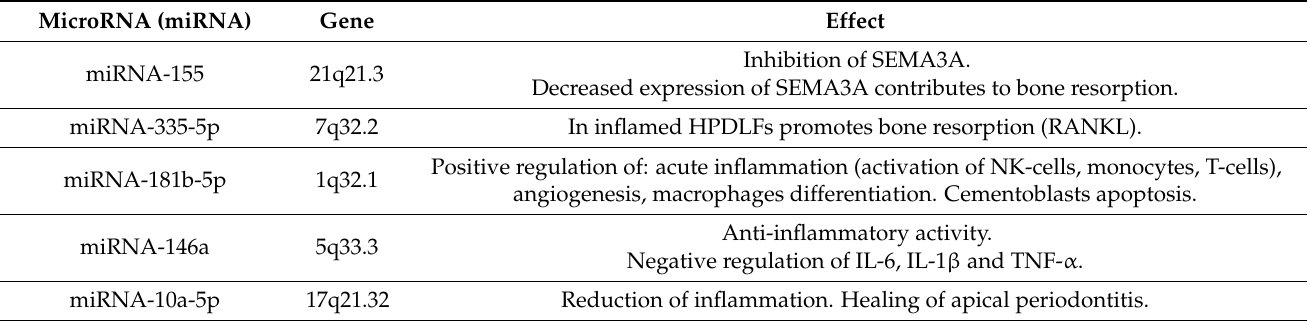
Table 2. Exemplary miRNA occurring within the periapical lesions on the basis of the literature [61,68–72]. MicroRNA (miRNA) Gene Effect Inhibition of SEMA3A. miRNA-155 21q21.3 Decreased expression of SEMA3A contributes to bone resorption. miRNA-335-5p 7q32.2 In inflamed HPDLFs promotes bone resorption (RANKL). Positive regulation of: acute inflammation (activation of NK-cells, monocytes, T-cells), miRNA-181b-5p 1q32.1 angiogenesis, macrophages differentiation. Cementoblasts apoptosis. Anti-inflammatory activity. miRNA-146a 5q33.3 Negative regulation of IL-6, IL-1 β and TNF- α . miRNA-10a-5p 17q21.32 Reduction of inflammation. Healing of apical